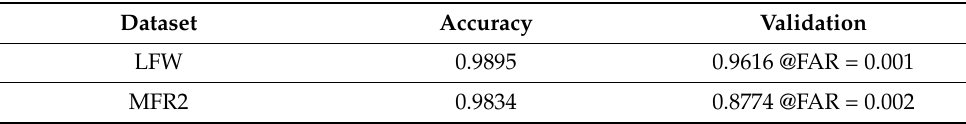
Table 2. Simulated VGGFACE2 verification on different datasets.